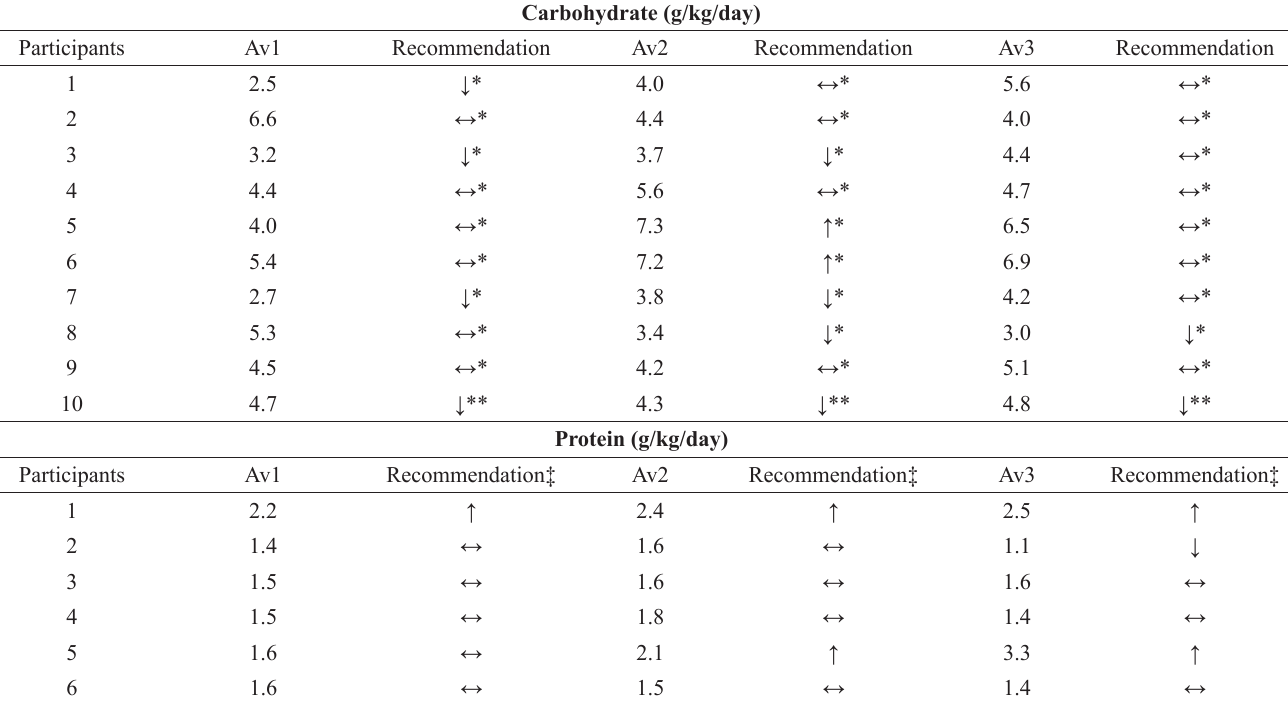
Table 4. Comparison of the carbohydrate, protein and lipid intakes with the recommended values, for each evaluated period, per